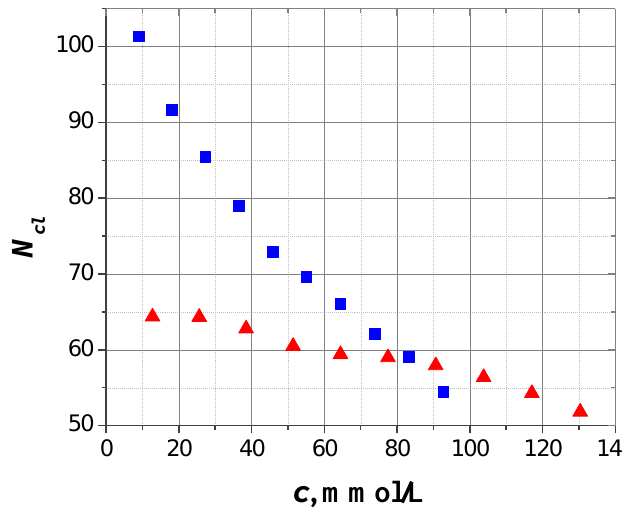
Figure 4. The concentration dependence of the effective number of water molecules in the shell around AMP (red triangles) and ATP (blue squares) molecule, formed by the dipole component and by its negative charges at 25 °C. Reprinted with permission from reference [10], (Copyright 2012, American Institute of